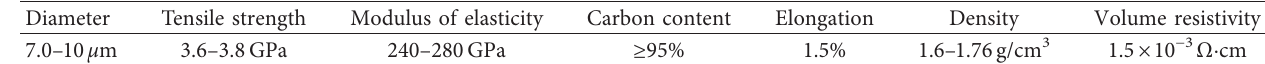
Table 9: Basic properties of PAN-based carbon fibers.